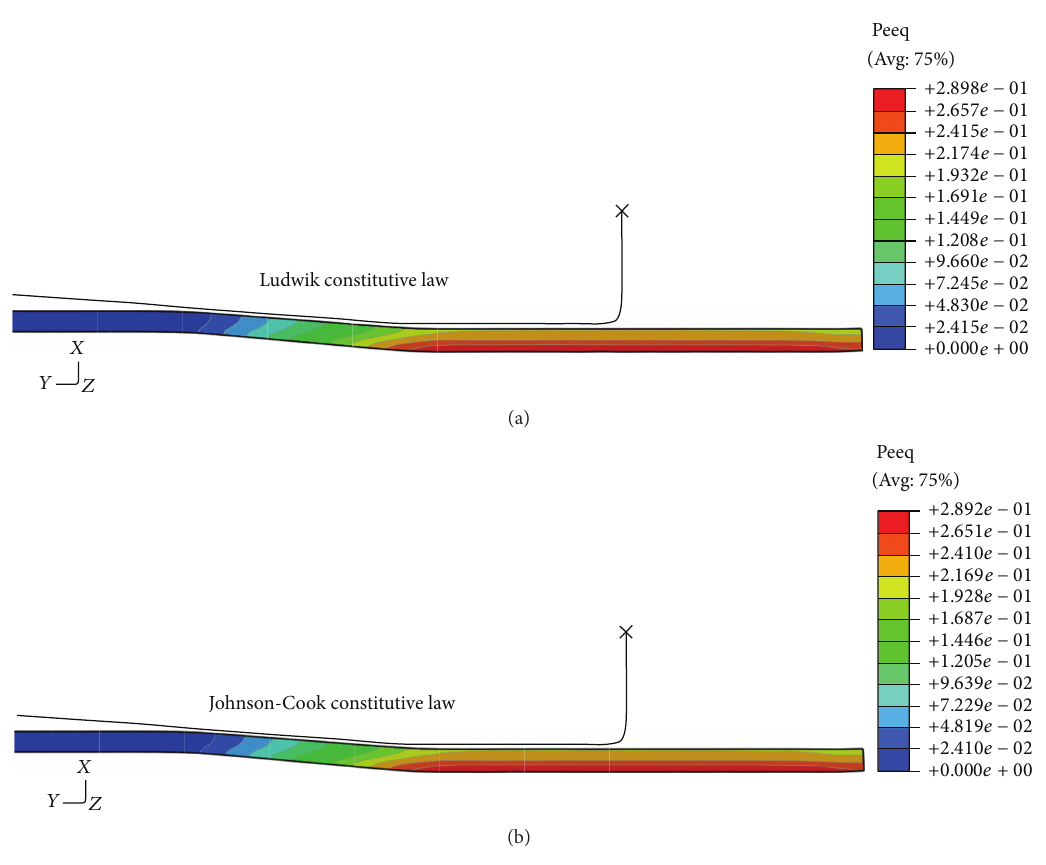
Figure 5: Equivalent plastic strain after forming. Table 1: Comparison between experimental [6] and computed loads.